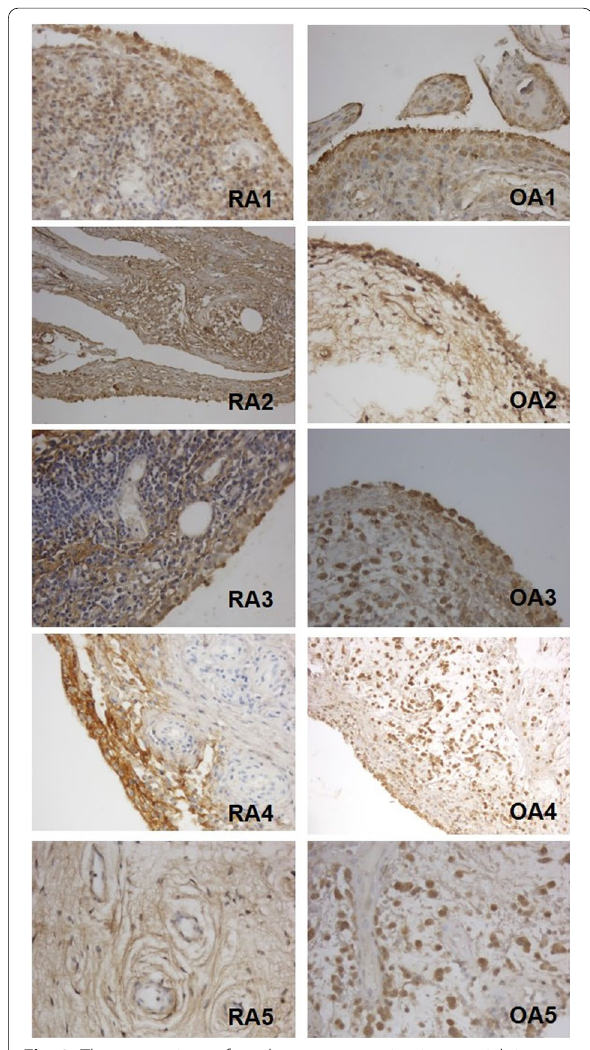
Fig. 2 The comparison of syndecan-4 expression in synovial tissue between 5 RA patients and 5 OA patients. RA: rheumatoid arthritis; OA: osteoarthritis